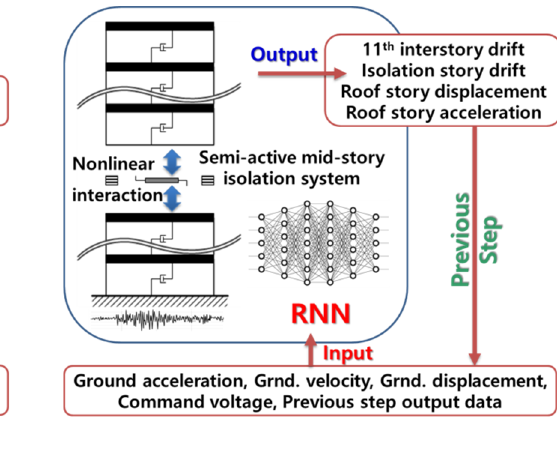
Figure 5. Input and output data of the RNN model: ( a ) RNN model for a building with semi-active TMD (Example 1); ( b ) RNN model for a building with SMIS (Example 2).